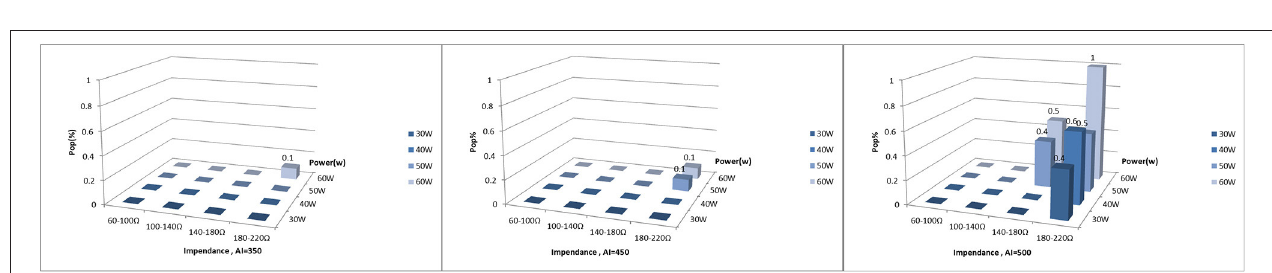
FIGURE 6 | The three bar charts show the proportion of steam pops under different combinations of basic impedance and power when the target AI is 350, 450, and 500, respectively. The x -axis represents R grouping, the y -axis represents the P setting, and the z -axis represents the proportion of steam